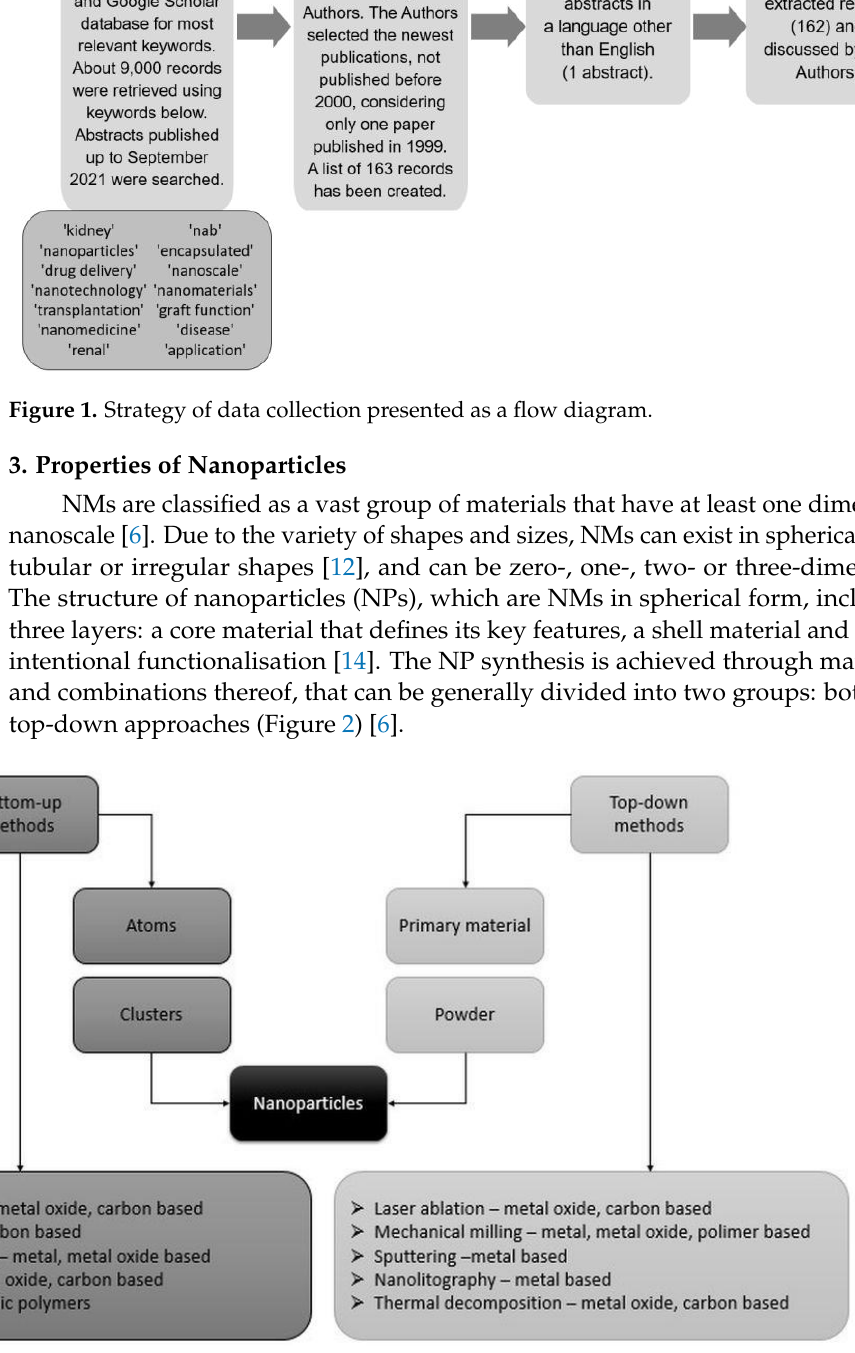
Figure 2. Diagram of nanoparticles synthesis processes and methods and the categories of nanopar- ticles synthesised from a given method (modified based on Saleh et al. [6]).